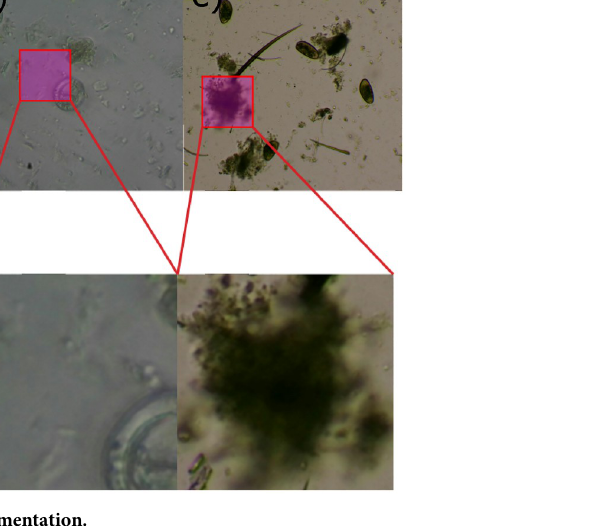
Fig 14. Examples of wrong